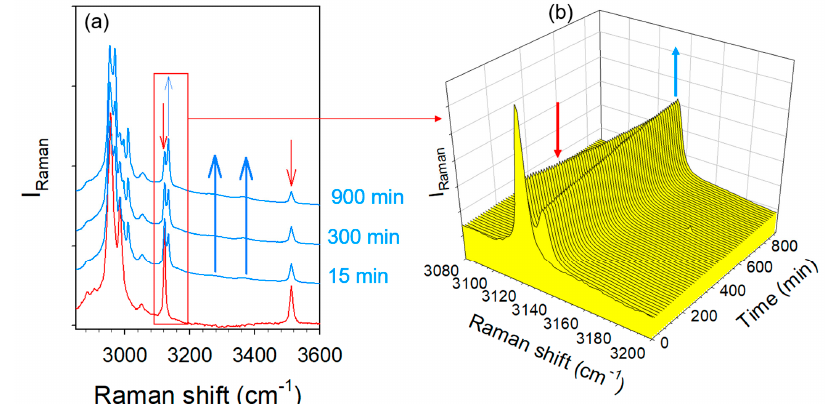
to 90% RH; ( a ) in the C–H and O–H stretching regions, the two blue thick arrows localizing the appearance of the broad O–H stretching bands distinctive of H-bonding with water molecules; ( b ) in the C–H stretching region distinctive of co-crystals forms 1 and